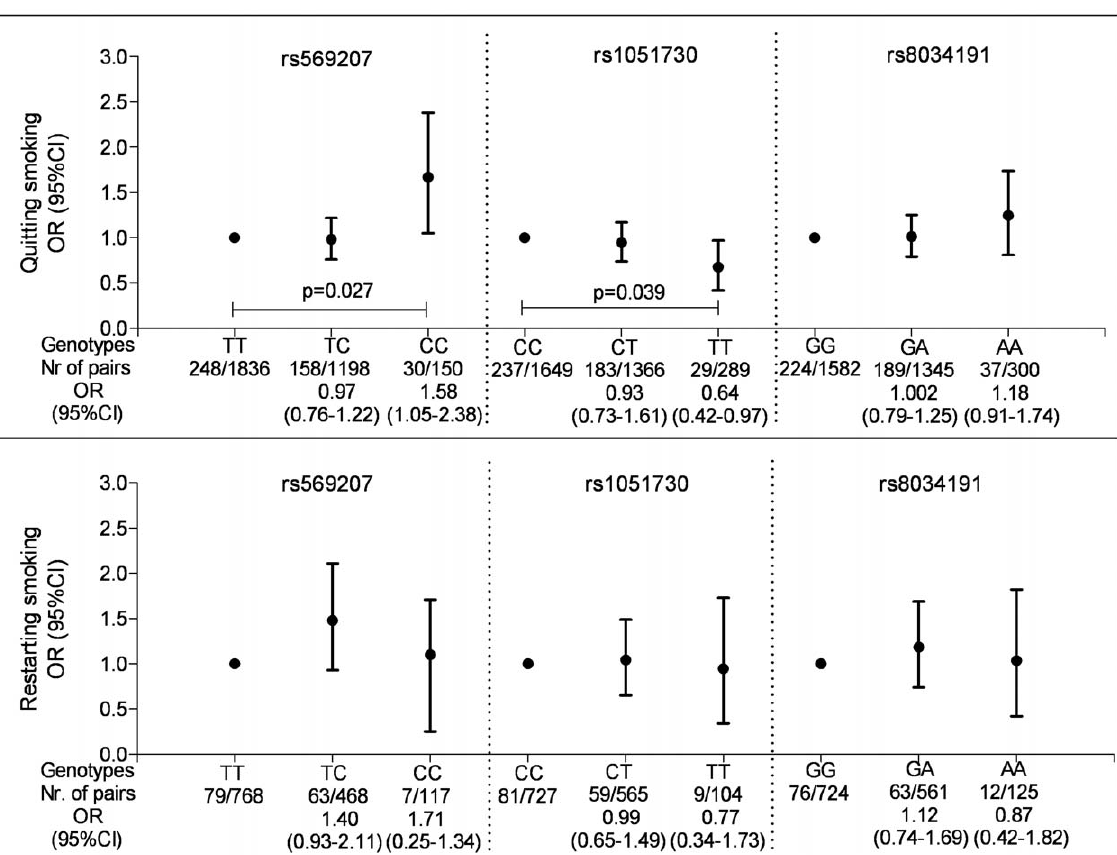
Figure 1. SNPs in the nAChR cluster and OR (95%CI) for quitting smoking in subjects who smoke (upper graph), and OR (95%CI) for restarting to smoke in ex-smokers (lower graph). Nr. of pairs=number of paired observations in which the subject stopped respectively restarted smoking/ total number of paired observations included in the analysis; Circles represent the odd ratio (OR) and vertical bars represent 95% confidence interval (CI); Wild type was set to one as the reference category; Different total number of paired observations for the SNP genotypes are due to missing data on genotype or smoking habits. The analyses are adjusted for gender and the time between 2 successive surveys. rs569207 TT=wild-type, TC=heterozygote, CC=homozygote variant rs1051730 CC=wild-type CT=heterozygote TT=homozygote variant rs8034191 GG=wild-type, GA=heterozygote, AA=homozygote variant.